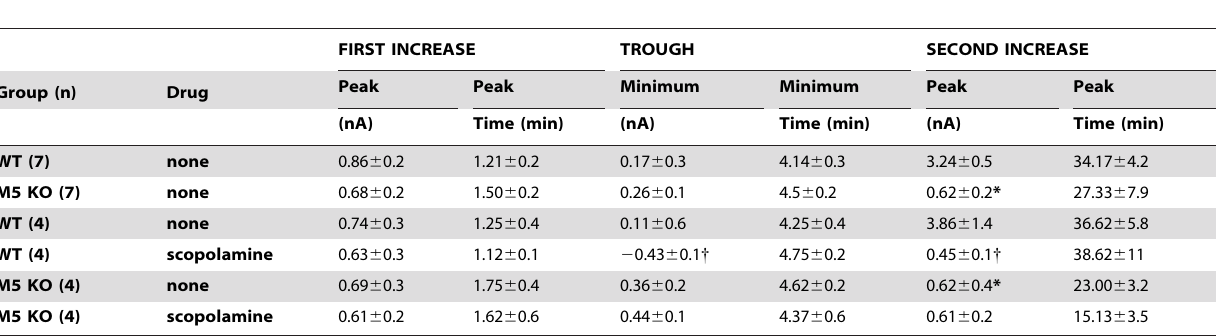
Table 1. Effects of PPT stimulation on dopamine oxidation current recorded from the striatum of wildtype (WT) and M 5 knockout (KO) mice before and after systemic administration of scopolamine (5 mg/kg, i.p.).